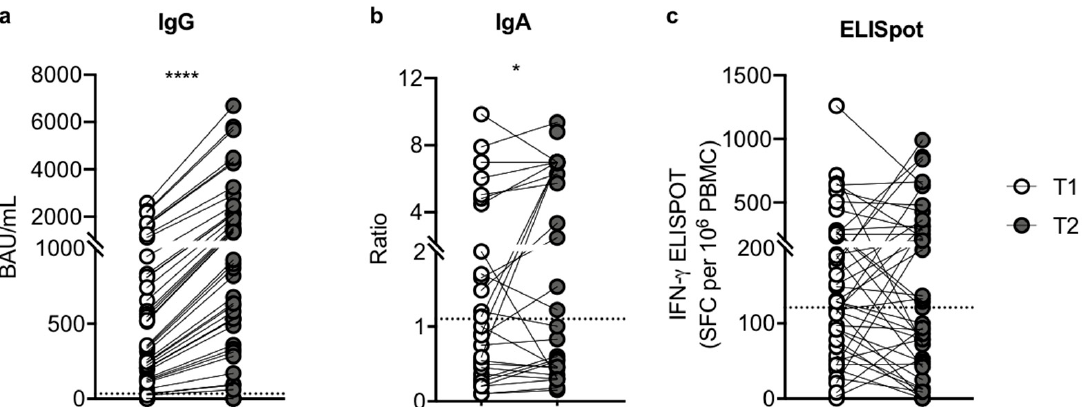
Figure 1. Humoral and cellular immune response to SARS-CoV-2 vaccination in SOTRs (n = 43) after the second (T1) and third (T2) dose of Pfizer-BioNTech BNT162b2 vaccine. ( a ) Comparison of anti-SARS-CoV-2 S1/S2 IgG concentration between T1 (white dots) and T2 (grey dots). Samples with anti-SARS-CoV-2 S1/S2 IgG concentration >33.8 BAU/mL were considered positive. ( b ) Comparison of anti-SARS-CoV-2 S1 IgA ratio between T1 (white dots) and T2 (grey dots). Ratios ≥ 1.1 were considered positive. ( c ) T cell responses (IFN- γ ELISpot SFC per 10 6 PBMC) to Spike were compared between T1 (white dots) and T2 (grey dots) in SOTRs. Each dot plot represents the normalized mean spot count from duplicate wells (2.5 ± 0.5 × 10 5 PBMC/well) for each subject after subtraction of the spot count of unstimulated cells. IFN- γ ELISpot > 112 SFC/10 6 PBMC were considered positive. The connection lines represent the antibody value of each subject at T1 and T2, while the dotted line corresponds to the threshold. The significance was determined using the Wilcoxon matched-pairs signed-rank test (two-tailed), **** p < 0.0001, * p =